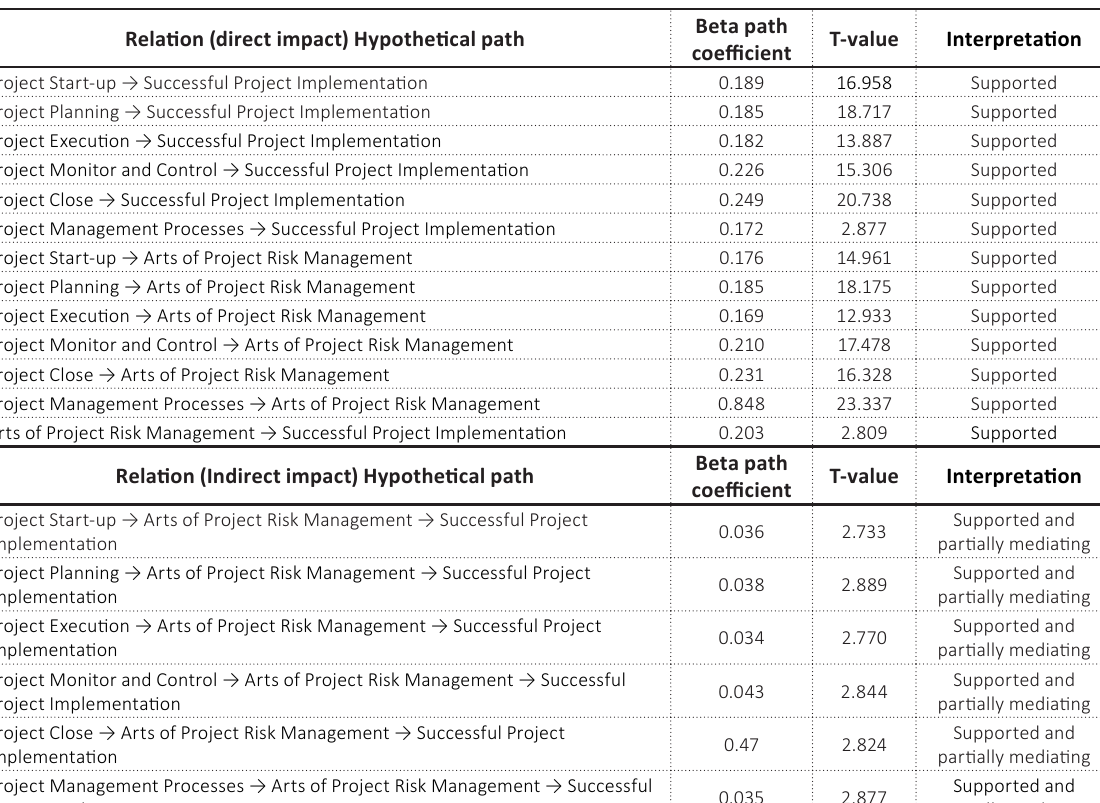
Table 6. Test results for all